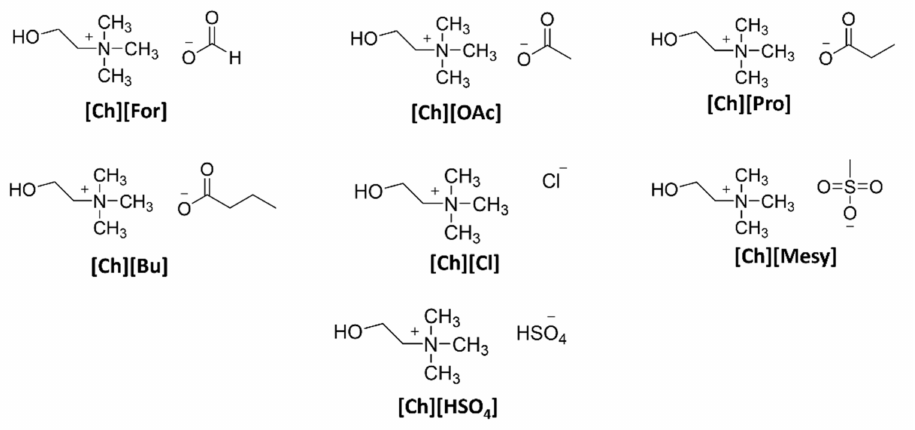
Figure 6. Main ILs reported in